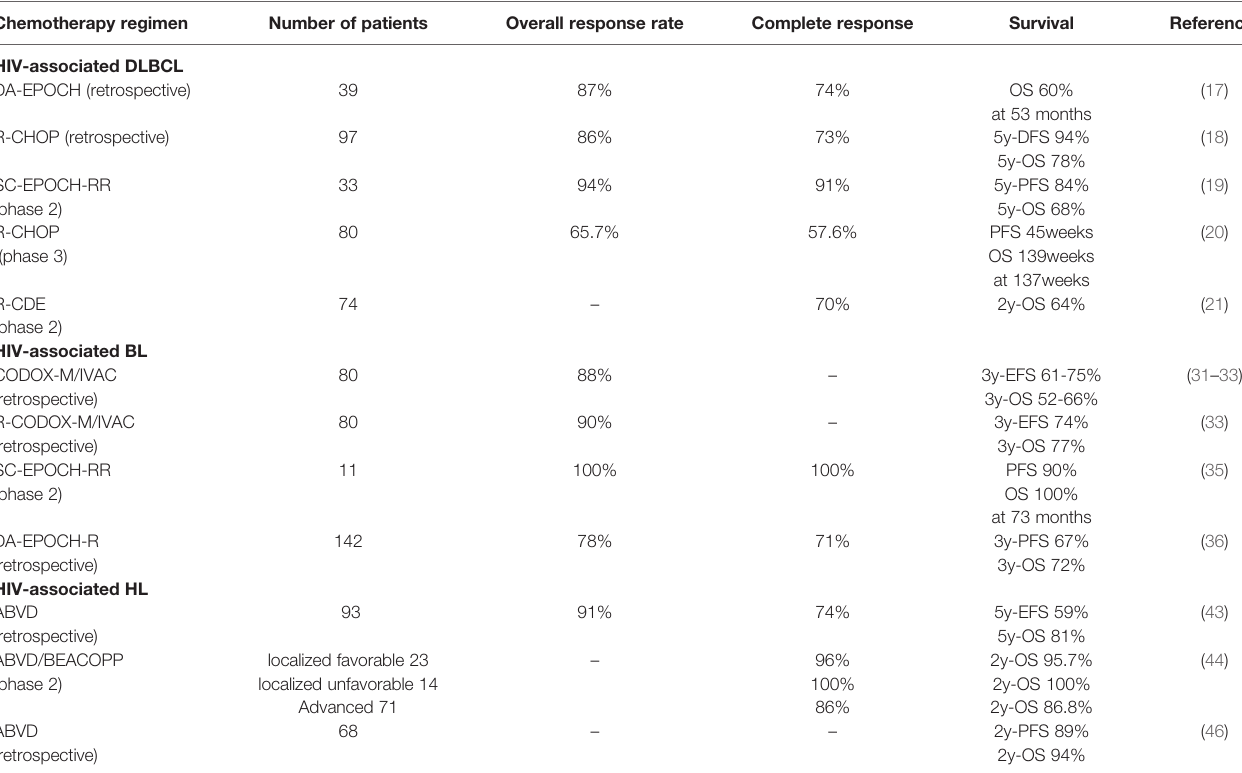
TABLE 1 | Front line chemotherapy for HIV-associated diffuse large B-cell lymphoma, Burkitt ’ s lymphoma and Hodgkin ’ s lymphoma in the cART